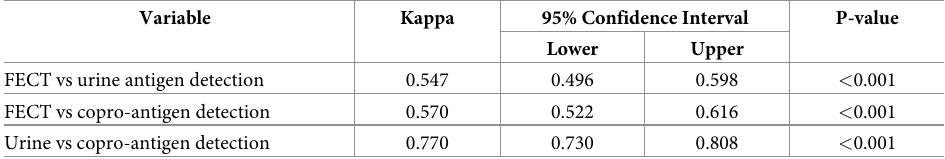
Table 5. Agreement (Kappa value) of diagnosis between the FECT and antigen detection